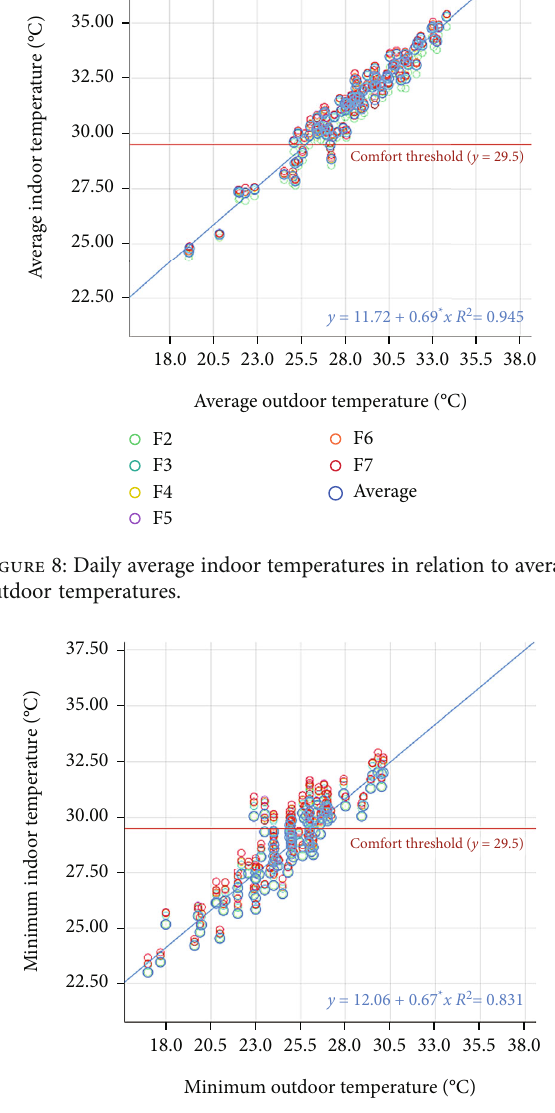
Table 1: Building parts.